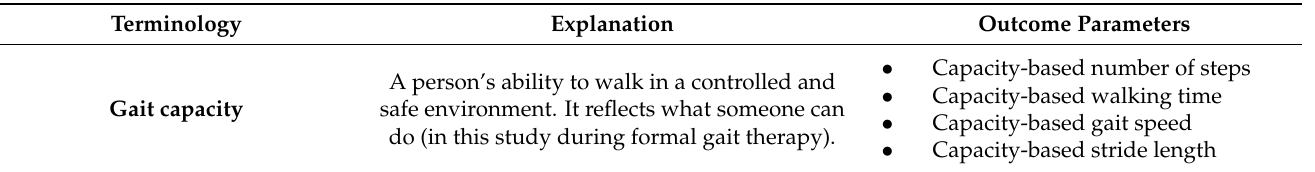
Table 1. Overview of used terminology and associated outcome